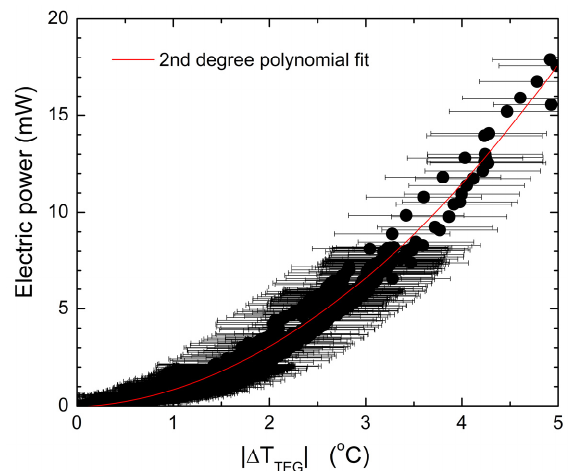
Figure 7. Electrical output power P TEG of a single TEG module experimentally obtained with both normal and reverse positions with respect to the heat flow as a function of the absolute value of temperature di ff erences at both TEG sides | ∆ T TEG | . Data available in the Supplementary Materials.